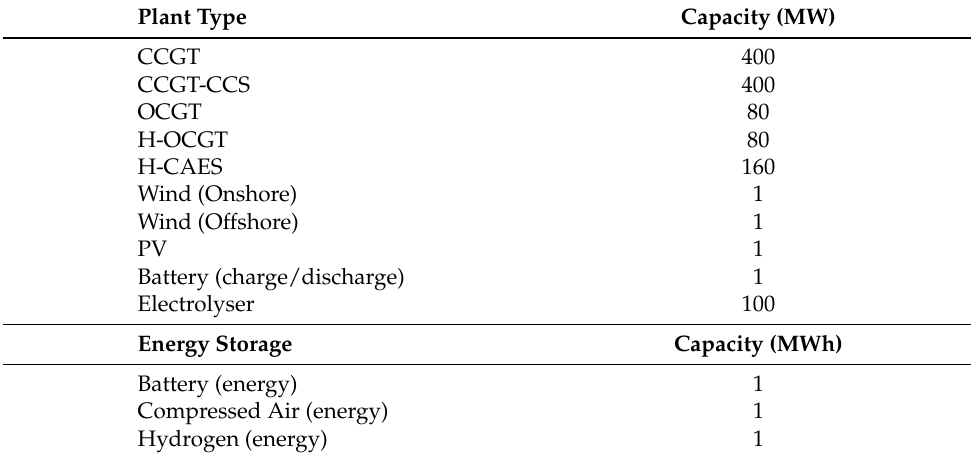
Table 2. Investment options and capacity available for